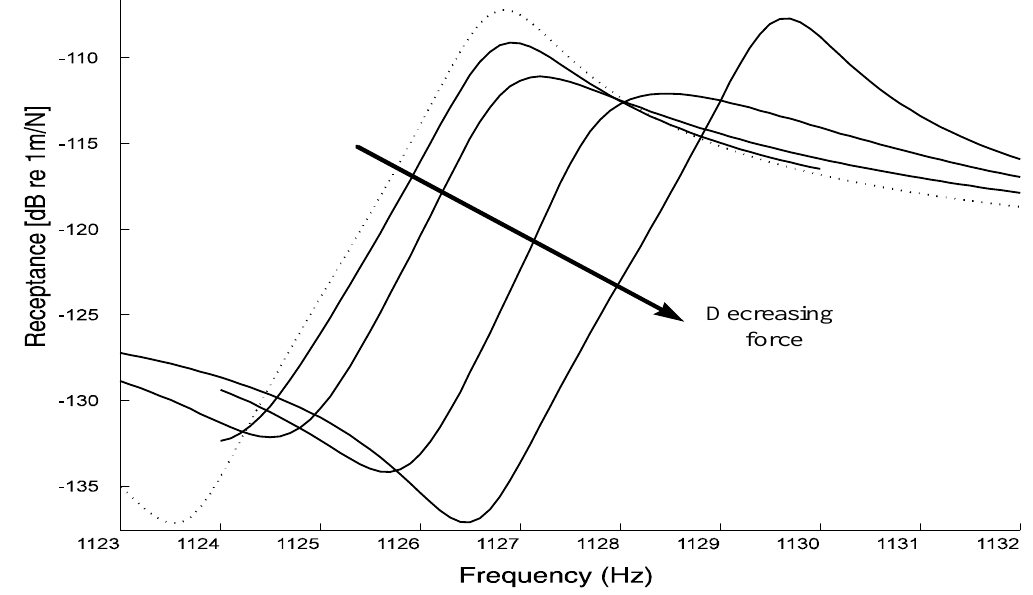
Fig. 10. Blade response at different excitation force levels: ... Linear response.